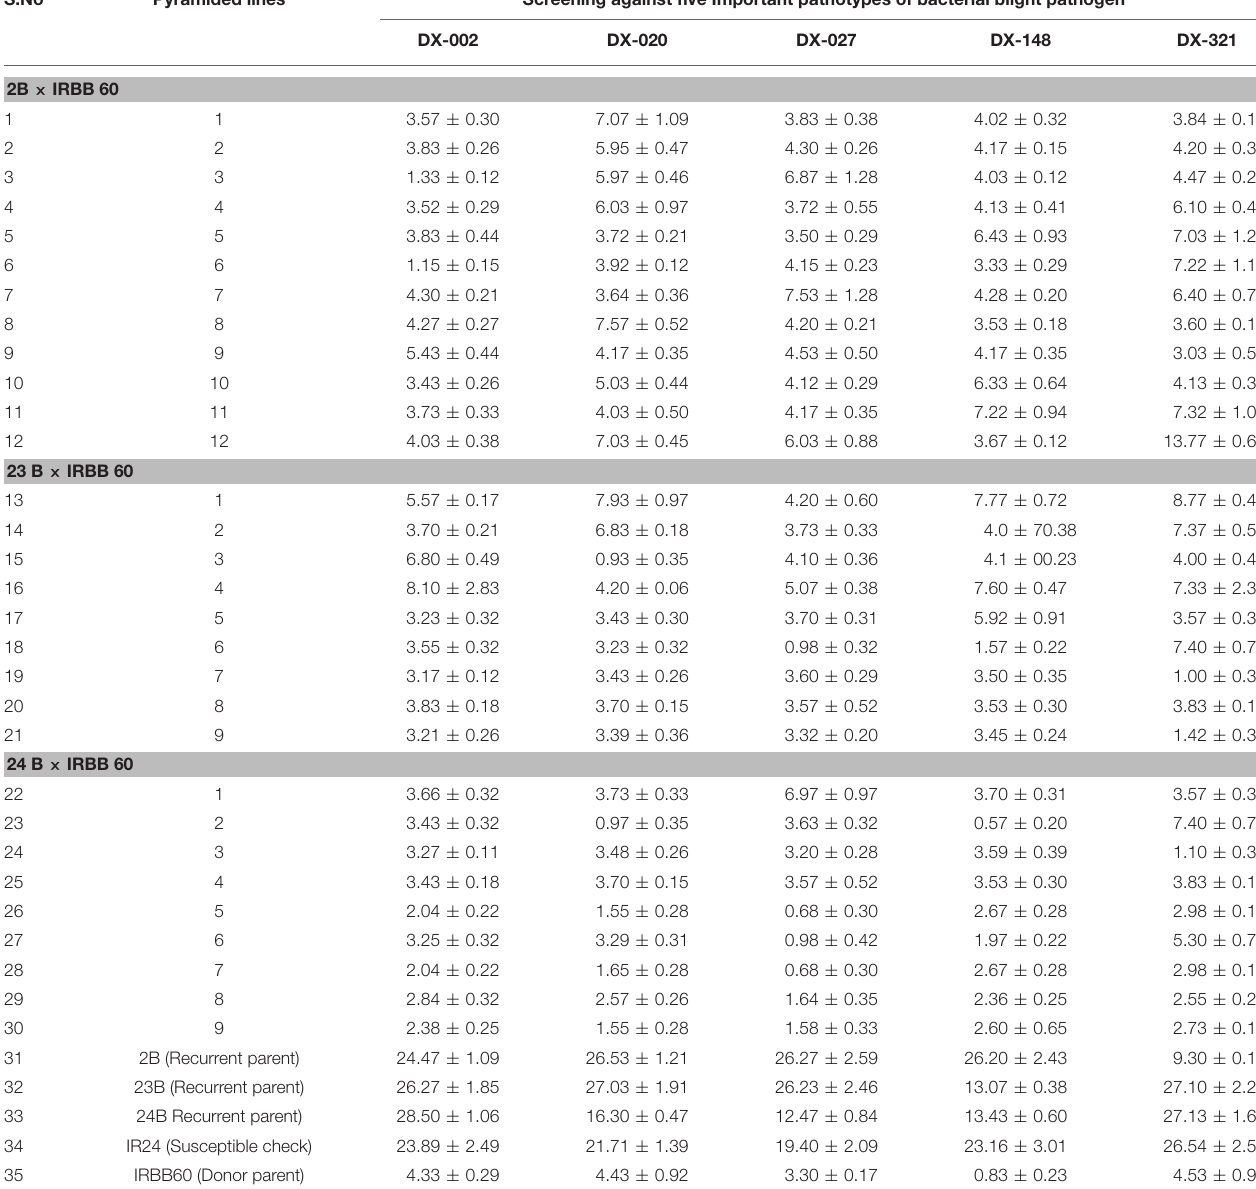
TABLE 3 | Mean lesion length of Xoo pathotypes on pyramided lines in BC 2 F 3 population. S.No Pyramided